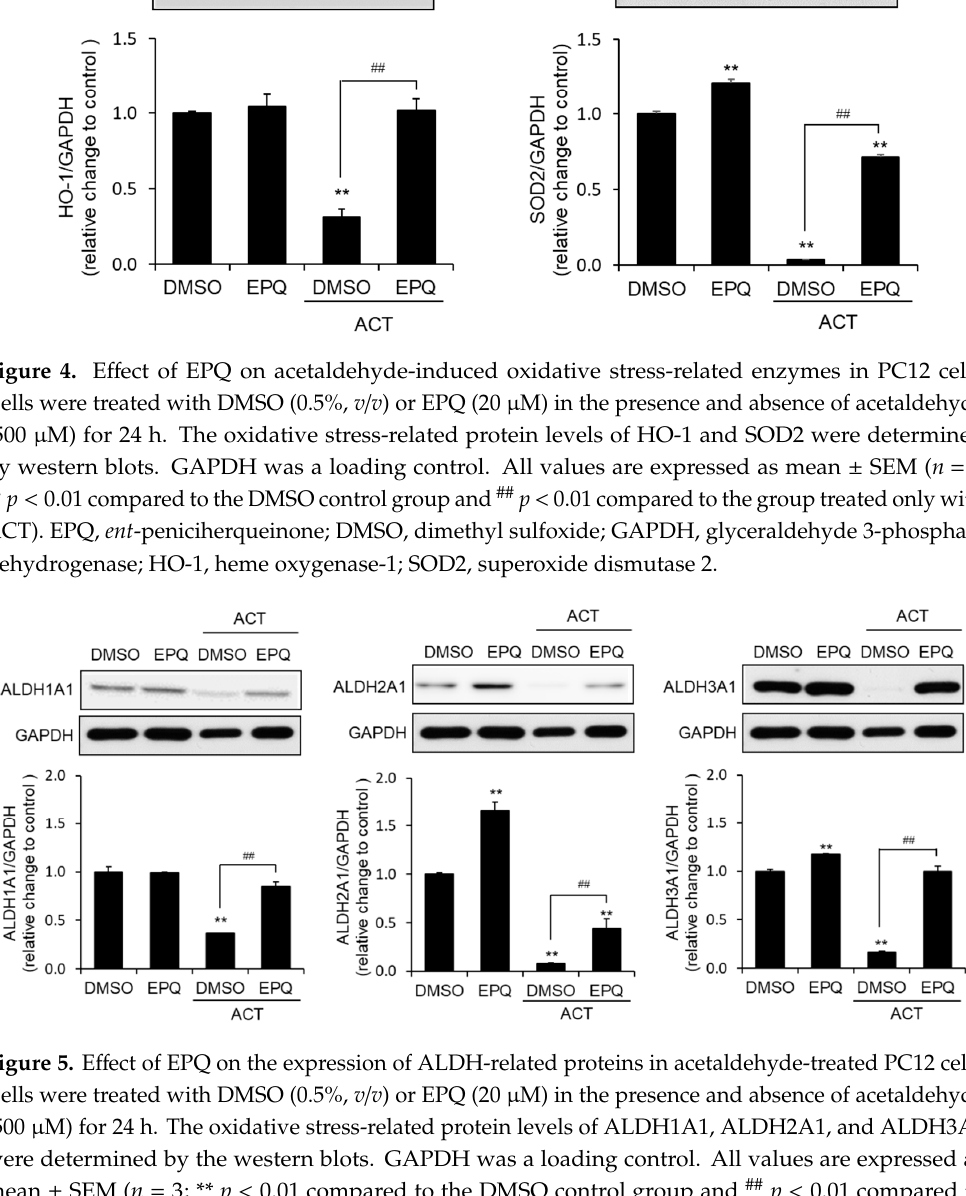
Figure 5. Effect of EPQ on the expression of ALDH-related proteins in acetaldehyde-treated PC12 cells. Cells were treated with DMSO (0.5%, v / v ) or EPQ (20 μ M) in the presence and absence of acetaldehyde (500 μ M) for 24 h. The oxidative stress-related protein levels of ALDH1A1, ALDH2A1,